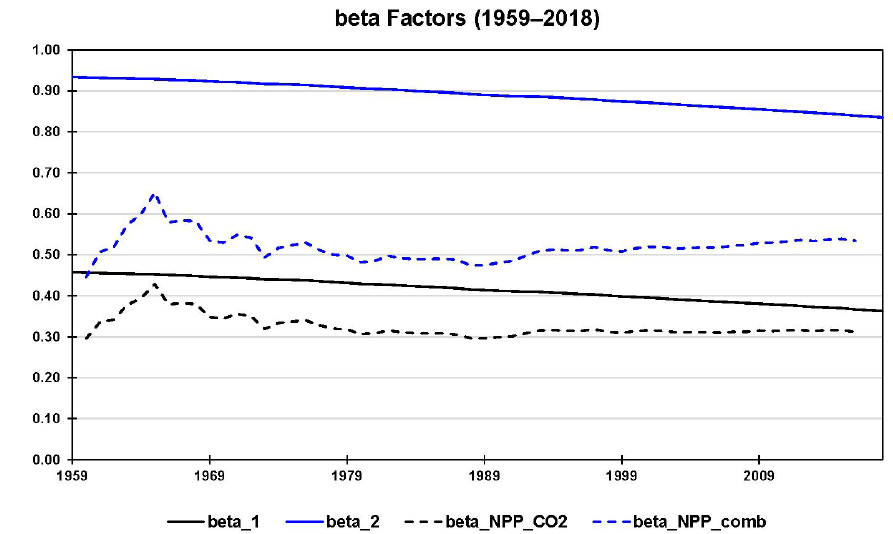
Figure 2. Using the lower ( β 1 ) and upper ( β 2 ) limits of the photosynthetic beta factor to test the range of the biotic growth factor ( β b ) for 1960–2016. The biotic growth factor is derived with the help of modeled net primary production (NPP) values accounting for CO 2 fertilization, nitrogen deposition, climate change, and carbon–nitrogen synergy. β NPP_CO the change in NPP due to CO 2 fertilization only, and β NPP_comb refers to the change in NPP due to the combined effect. All beta factors are in units of